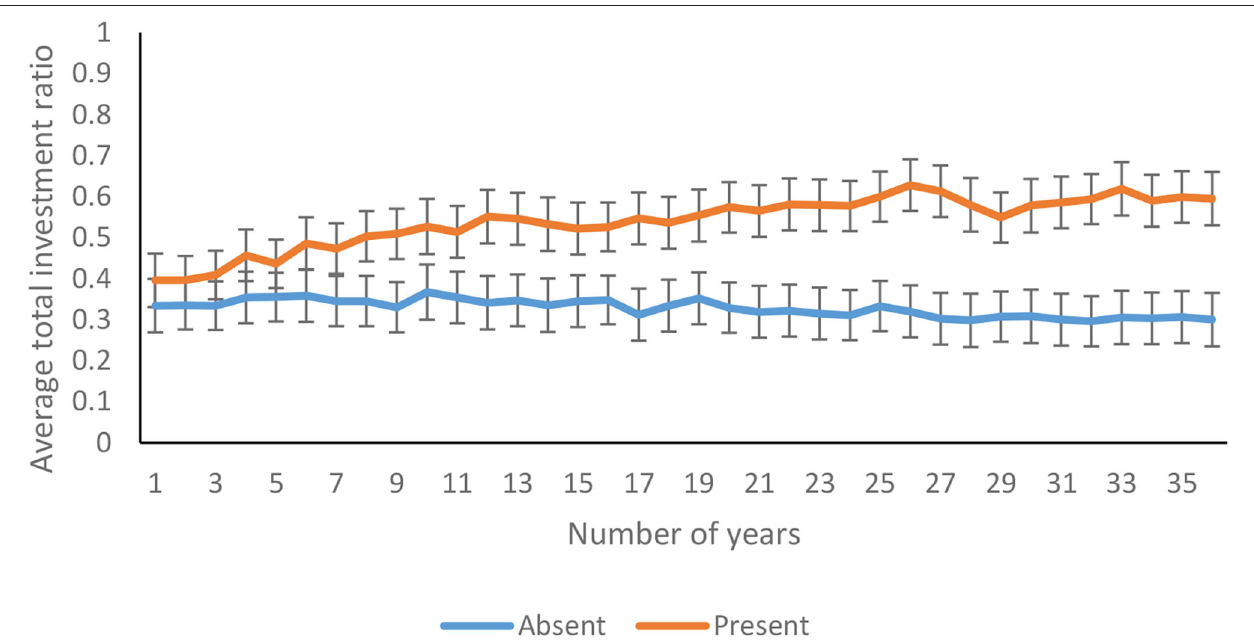
FIGURE 8 | Average total investment ratio over years in feedback-present and absent conditions. The error bars show 95% CI around the point